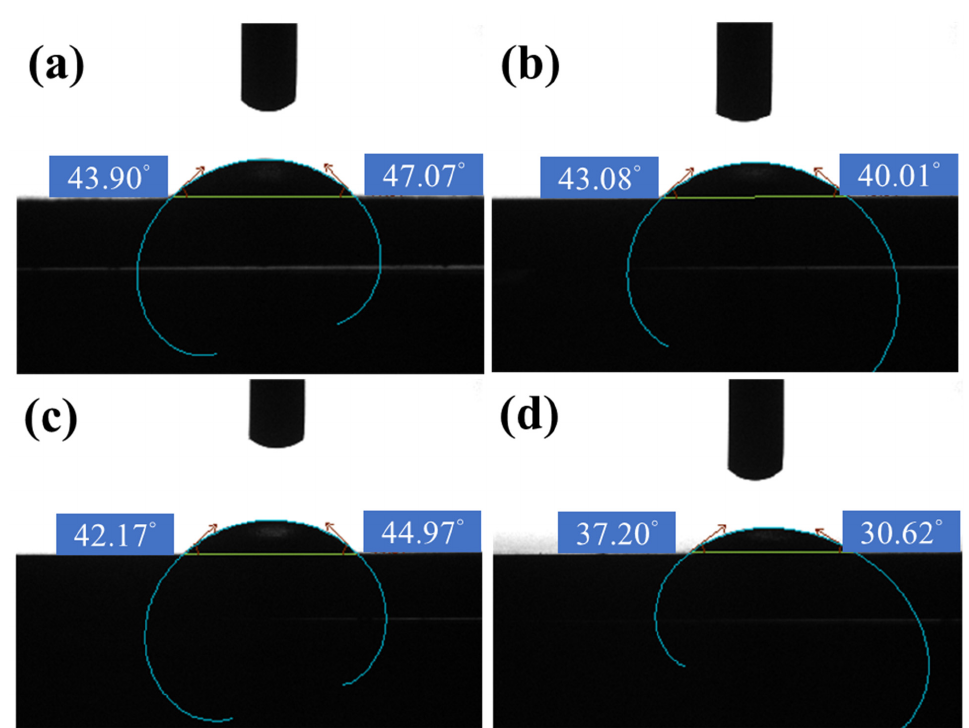
Figure 4. The contact angle for LZ91 Mg alloy after acid pickling pretreatment for ( a ) 30 s, ( b ) 60 s, ( c ) 90 s, and ( d ) 120 s. Nanomaterials 2022 , 12 , x FOR PEER REVIEW The corrosion behavior of samples was determined by potentiodynamic techniques.